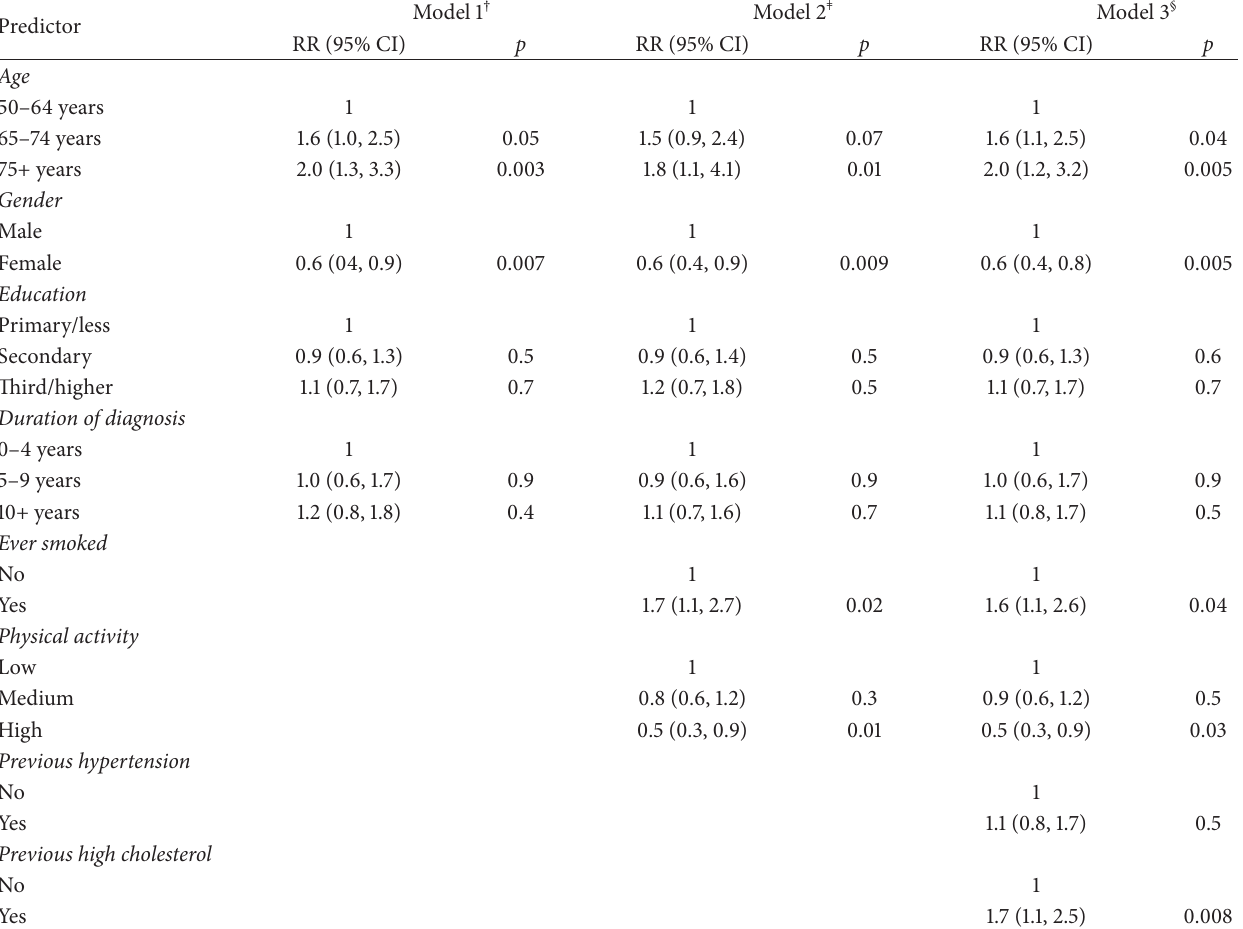
Table 2: Multivariate binomial regression models exploring independent associations between macrovascular complications and predictor variables ∗